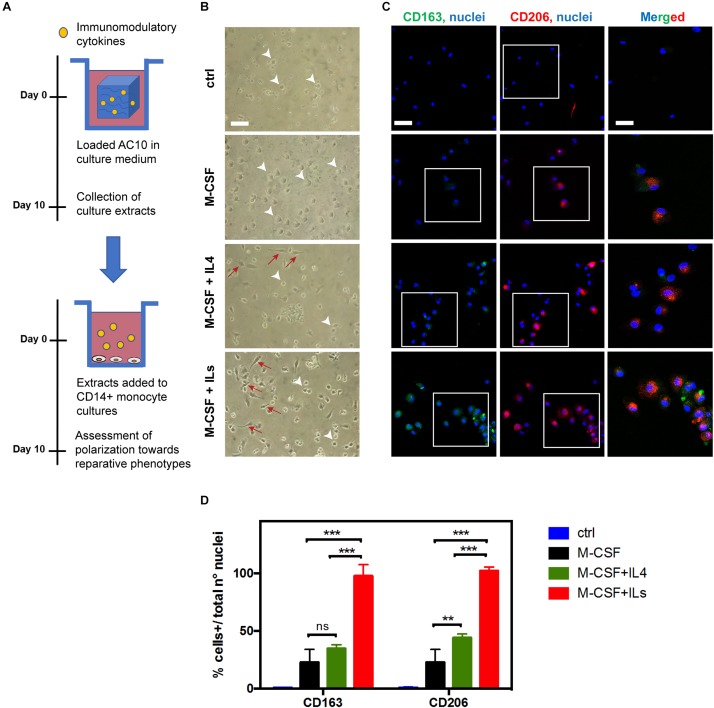
Optimized combinations of immunomodulatory cytokines released from AC10 hydrogels promote monocytes polarization toward healing macrophage phenotypes. (A) Isolated human CD14 + monocytes were cultured for 10 days in the presence of medium containing cytokines obtained from solid hydrogels after 10 days of incubation. (B) Representative optical light microscopy showing inflammatory macrophages phenotypes characterized by the round morphology (white arrowheads) and anti-inflammatory macrophage subsets with elongated morphology (red arrows). Scale bar = 50 μm. (C) Confocal images obtained from the specified conditions. Expression of M2-macrophage markers, CD163 (green) and CD206 (red) was evaluated. Scale bar = 50 μm. Nuclei were counterstained with Hoechst 33342 (blue). Rectangles in panel (C) represent cells in magnified area, where merged CD163/CD206/nuclei signals are shown (Scale bar = 20 μm). (D) Number of CD163 + or CD206 + cells was expressed as total positive cell per total nuclei number per analyzed field (ns = p > 0.05, **p < 0.01; ***p < 0.001, n = 3).